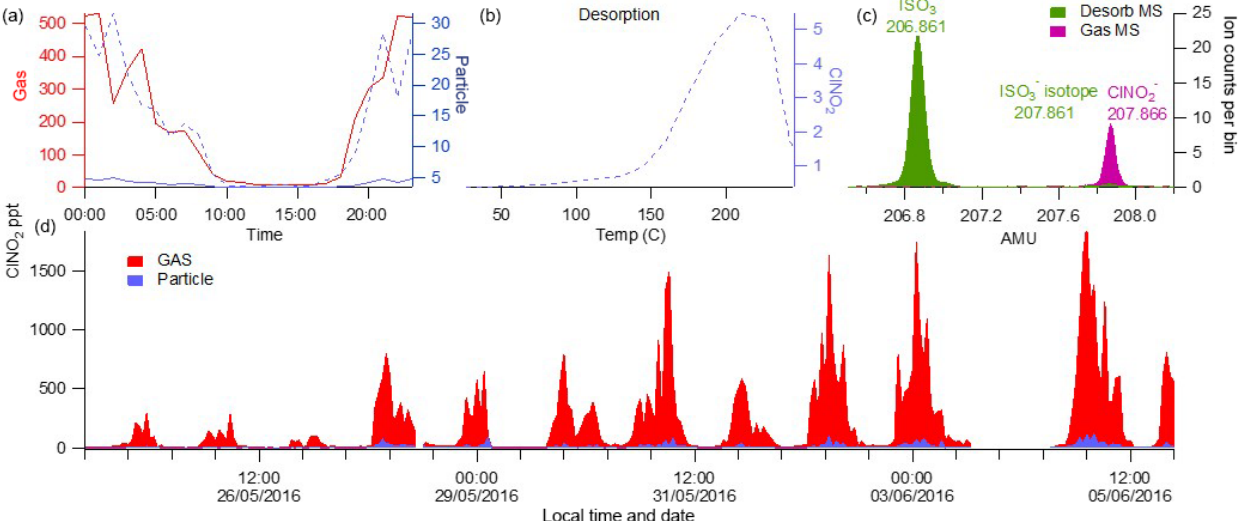
Figure 5. ClNO 2 gas- and particle-phase campaign time series (1h averaged) (a) and average diurnal profiles (b) . The peak fitting for ClNO 2 and the SO 3 interfering mass at 207–208 AMU (c) and the desorption profile for the counts attributed to the high-resolution ClNO 2 peak (d)